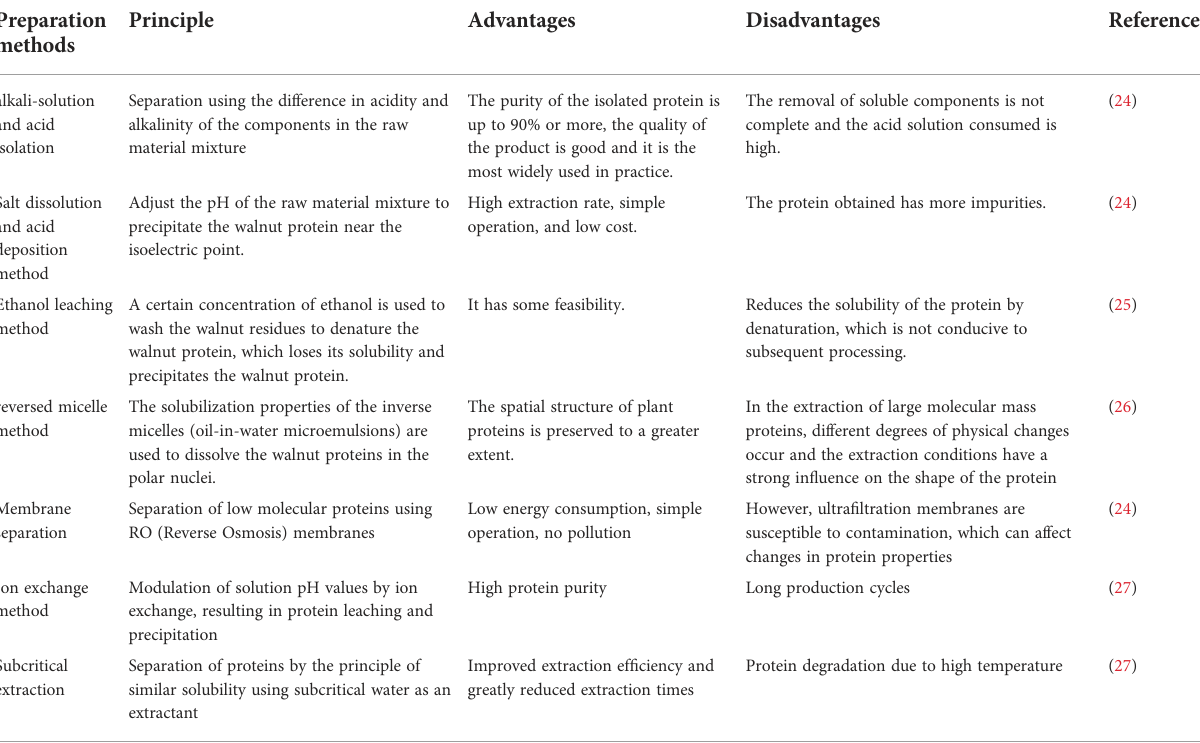
TABLE 2 Walnut protein preparation methods and their advantages and disadvantages.